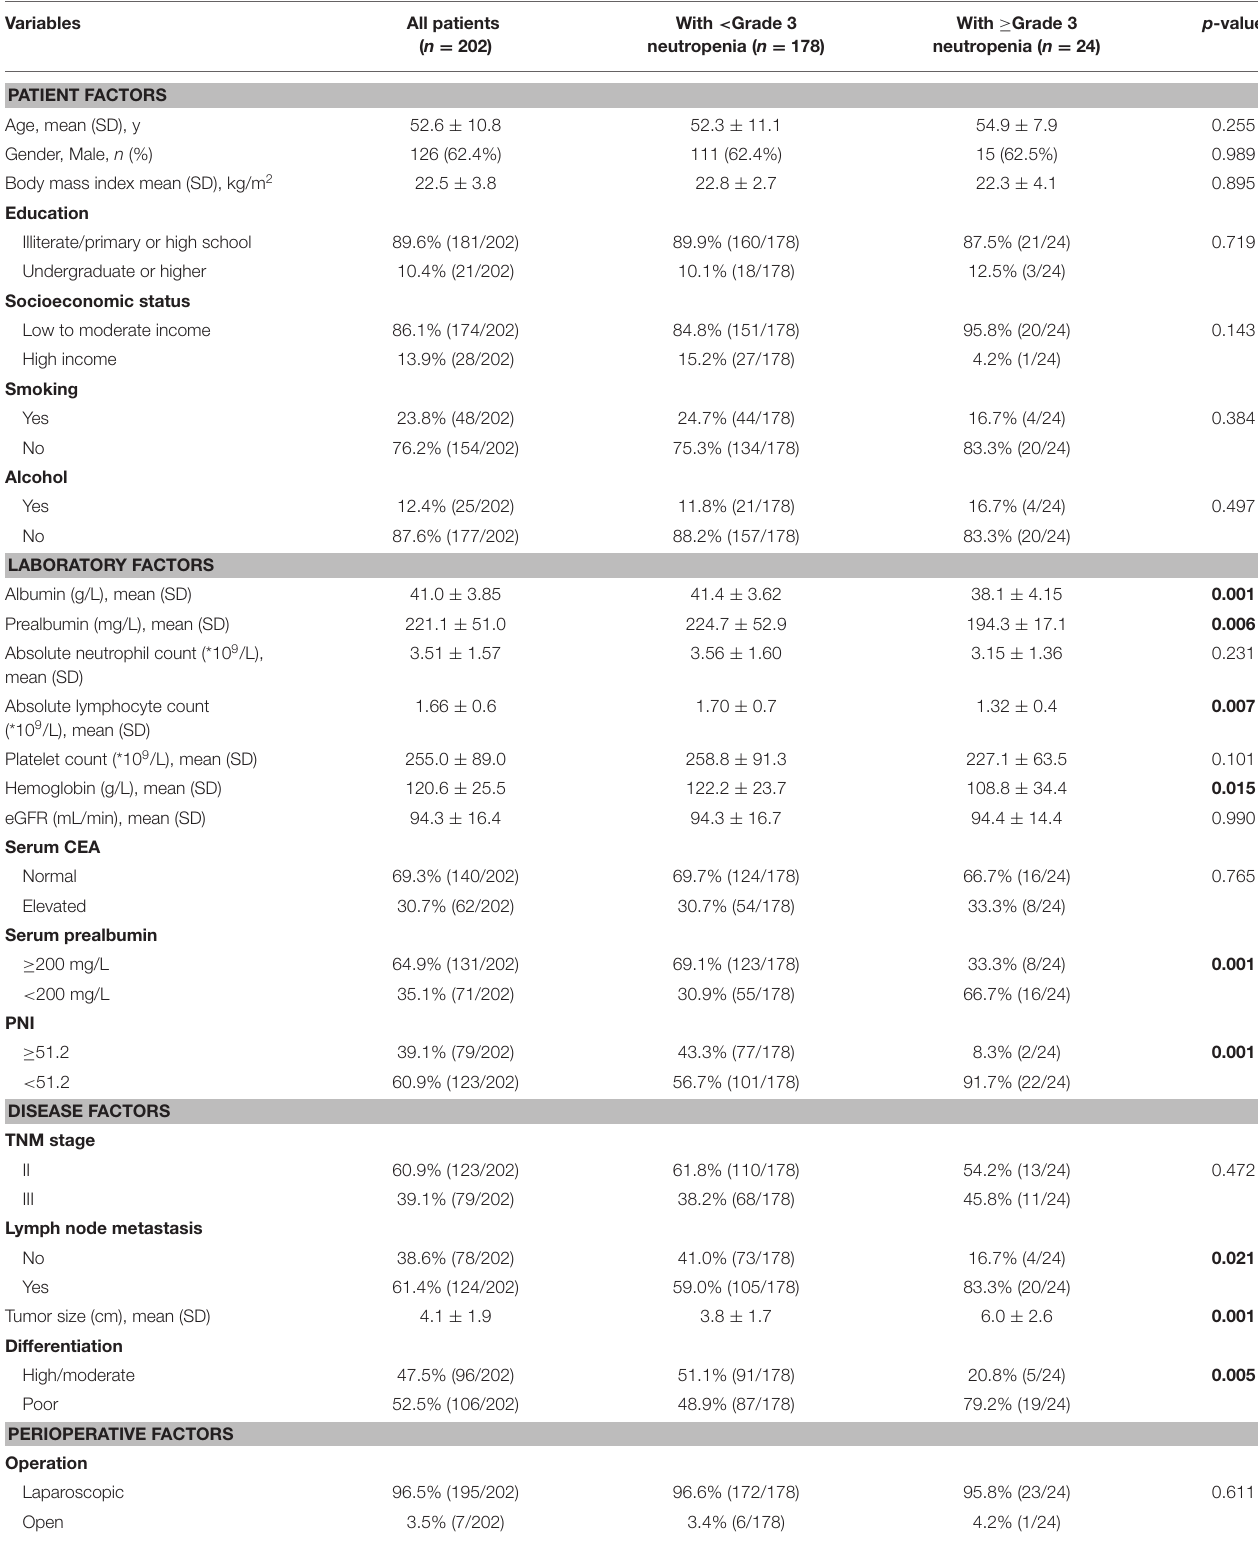
TABLE 1 | The demographic and clinical characteristics of patients in cycle 1. Variables All patients